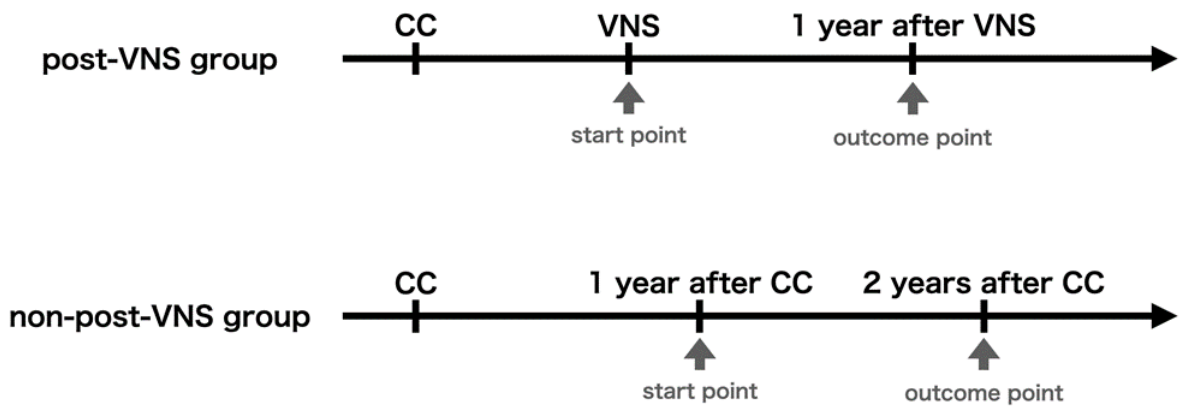
Figure 1. We defined the start point as the time before vagus nerve stimulation (VNS) in the post-VNS group and as 1 year after corpus callosotomy (CC) in the non-post-VNS group. Outcome points were defined as 1 and 2 years after the start point in both groups (this figure only shows the outcome point at 1 year after start point). In the non-post-VNS group, the outcome point 1 year after the start point corresponds to the time 2 years after CC.